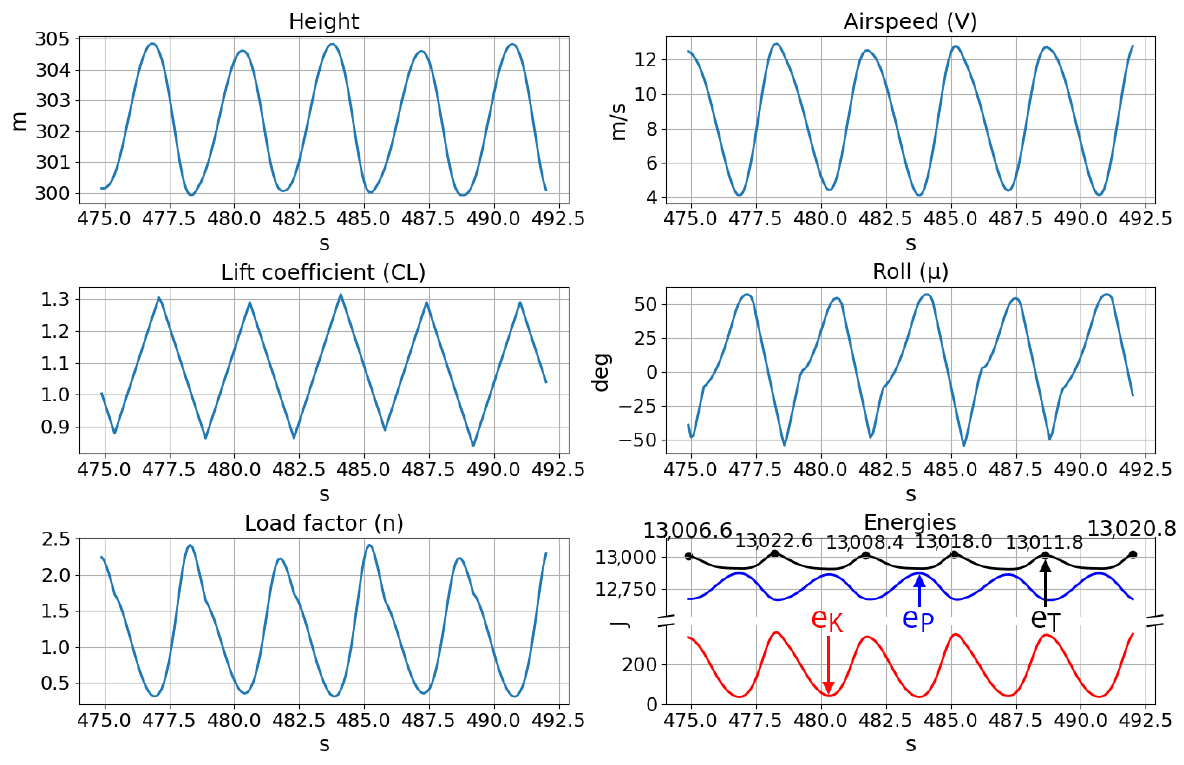
Figure 15. Trajectory trace of the dynamic soaring SUAV neurocontroller.